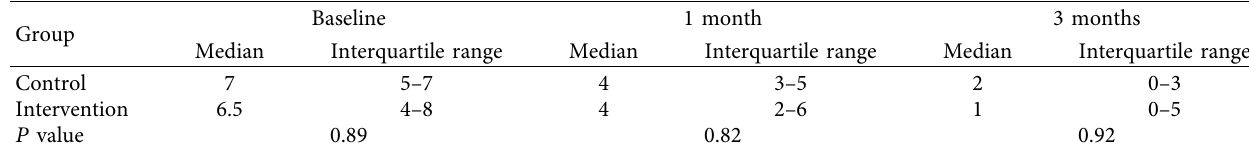
Table 2: Relative percentage of healing at 1 and 3 months, compared with baseline in the two groups.